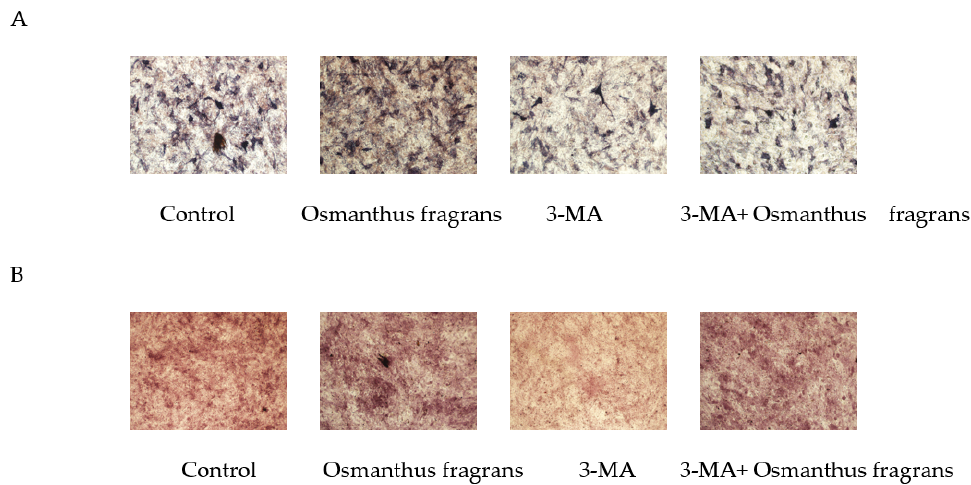
Figure 12. The 3-MA attenuates the osteogenic-differentiation-promoting effect of osmanthus fragrans extract: ( A ) ALP staining; ( B ) alizarin red staining.